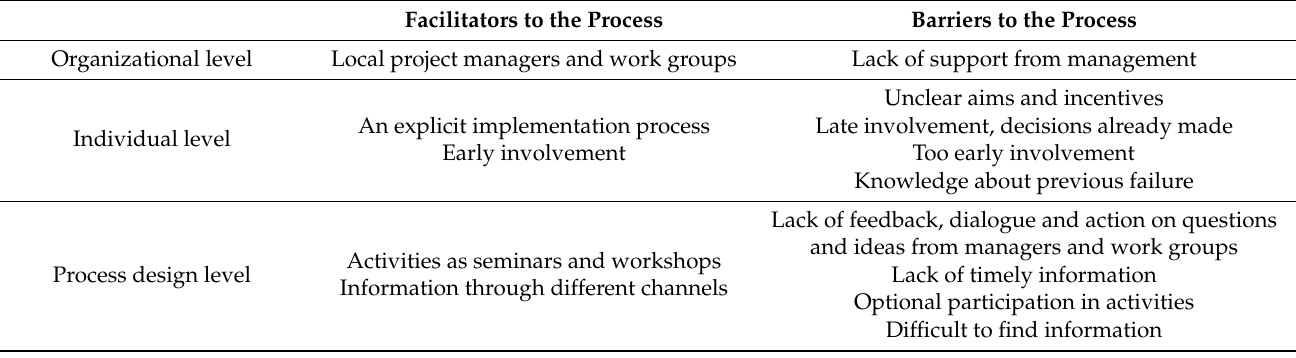
Table 4. A summary of implementation barriers and facilitators related to the organization, individual, and process